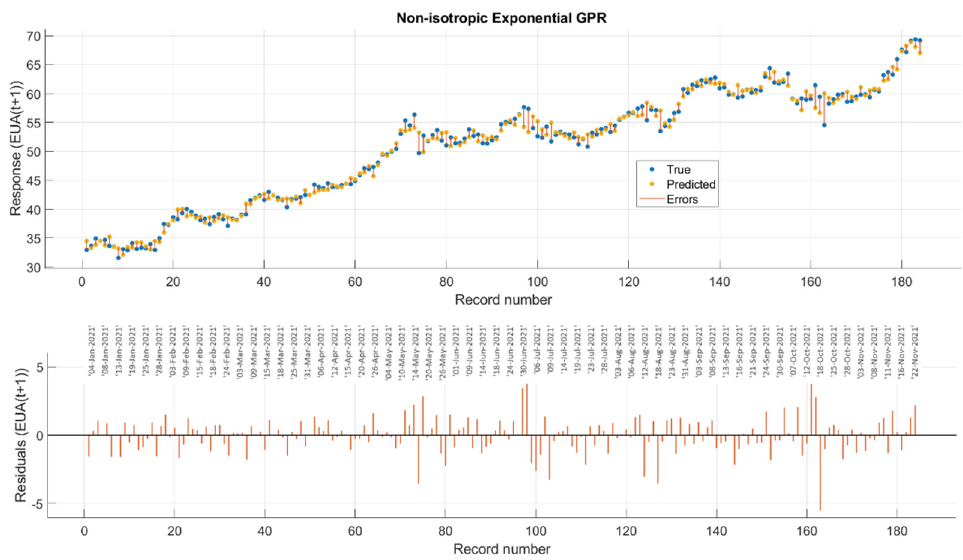
Figure 12. Predicted and true values of day-ahead carbon price and residuals using Non-isotropic Exponential GPR (for train data).